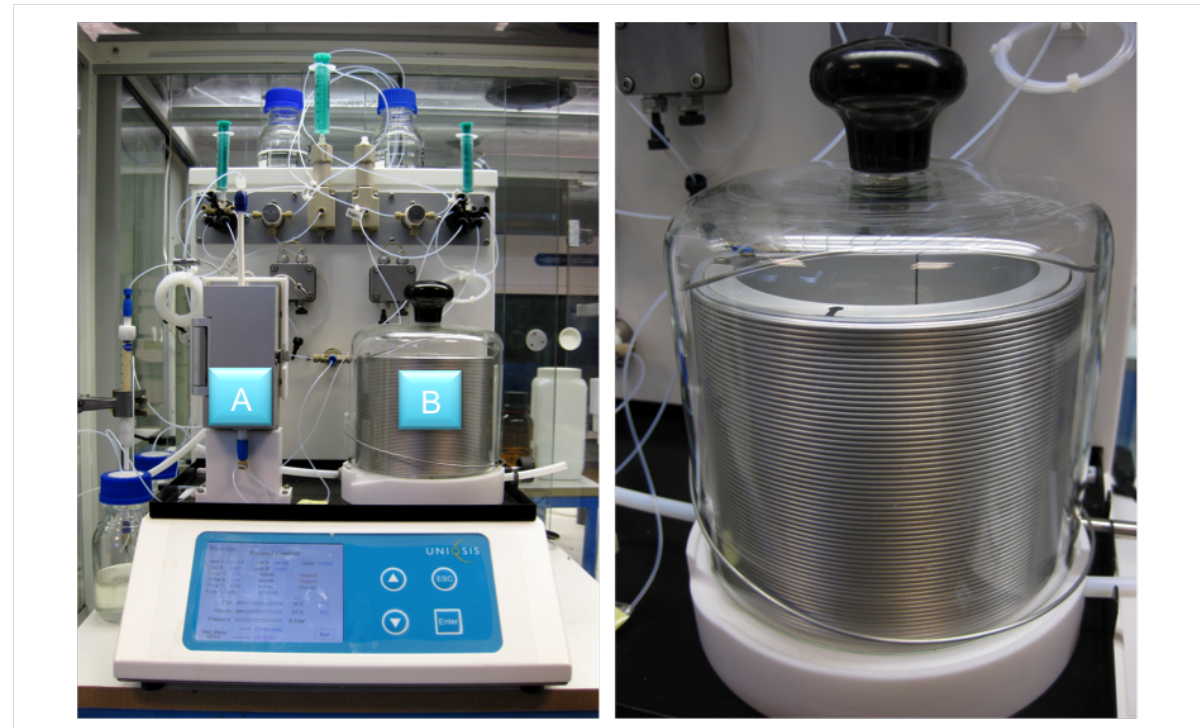
Figure 1: The Uniqsis FlowSyn™ continuous flow reactor comprising of a column holder and heating unit (A) and the reactor coil (B). A detailed image of the reactor coil is shown on the right.